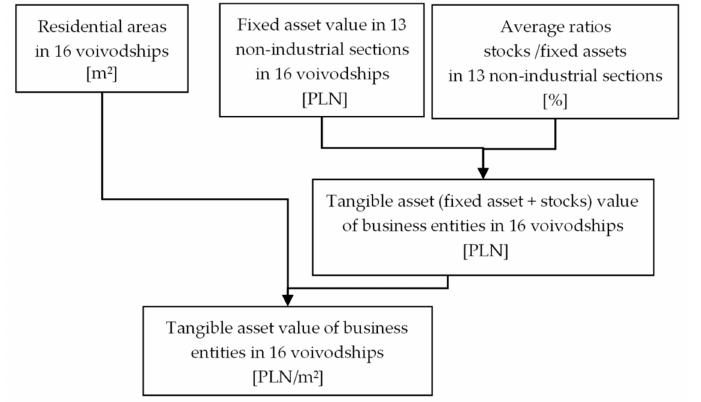
Figure 3. Approach to estimating asset values of business entities in residential areas for 16 voivod-